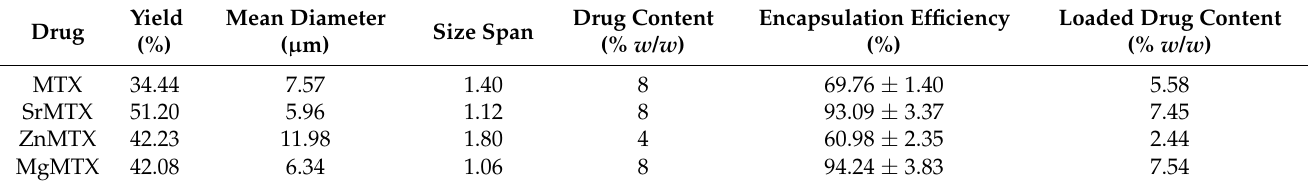
Table 2. Characterization of chitosan microparticles loaded with MTX and its derivatives.